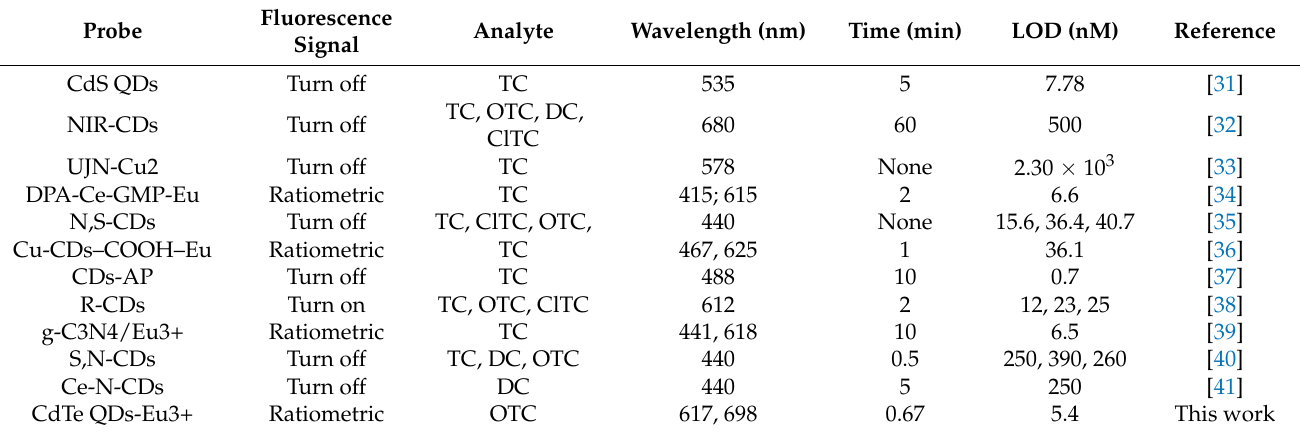
Figure 3. ( a ) Photoluminescence and ( c ) absorption spectra of mixed CdTe QDs and Eu 3+ solution upon addition of (0–10) µ M OTC with the concentration interval of 1 µ M. The linear relationship graph of ( b ) I 617 /I 698 and ( d ) absorbance at 386 nm with increasing concentration of OTC. Table 1. Comparison of different fluorescent probes for TCs